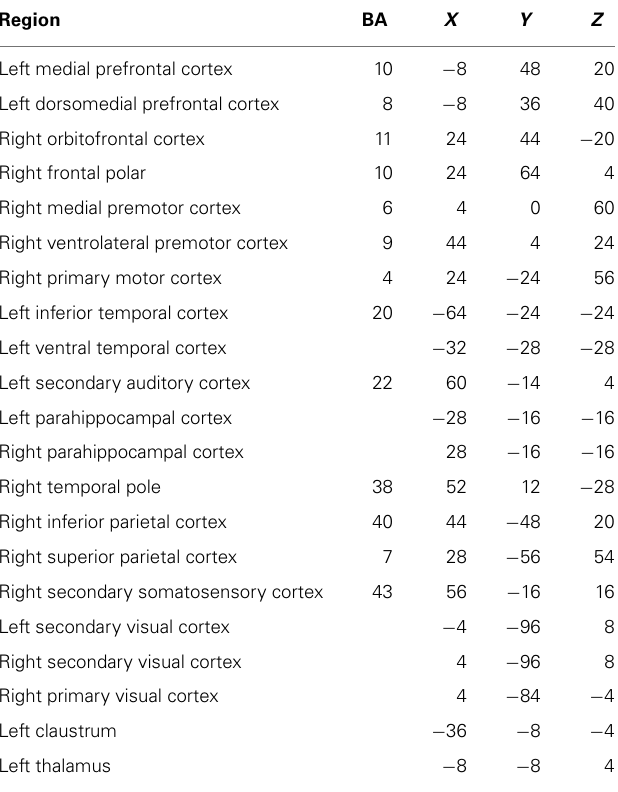
Table 2 | Each region in the network showing reduced connectivity in children withASD, together with associated Brodmann areas (BA) andTalairach coordinates.